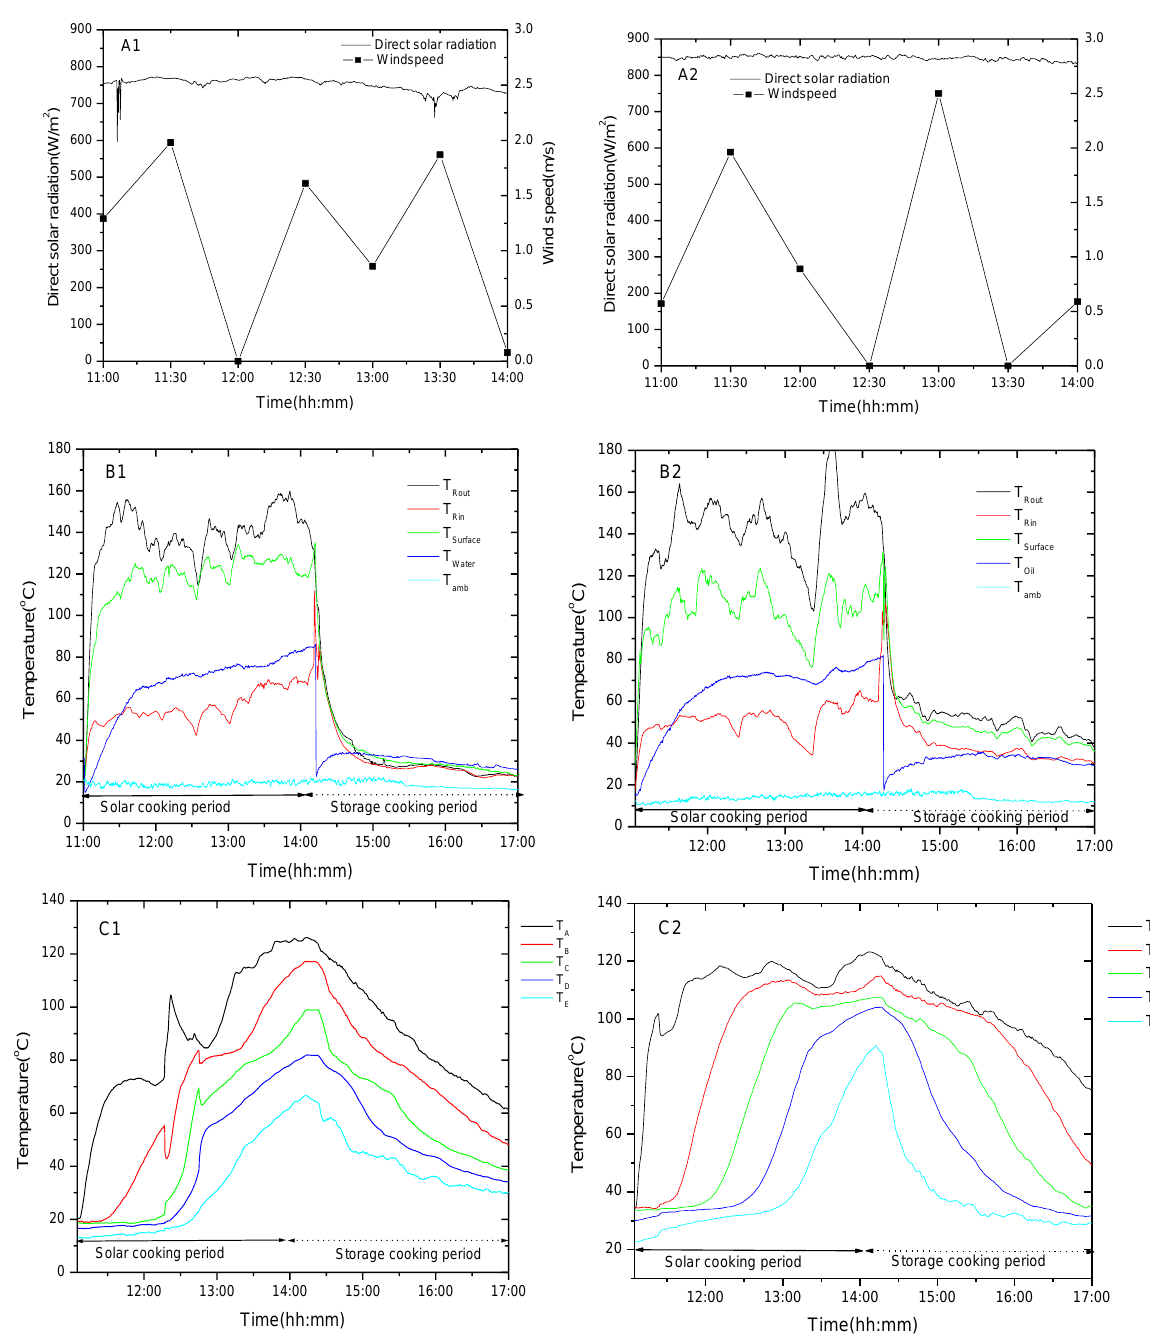
Figure 5. Experimental results of two test loads (water and sunflower oil) for a load of 1.0 kg utilizing a flow rate of 2.0 mL/s. ( A ) Direct solar radiation and wind speed ( A1 — water, A2 — sunflower oil), ( B ) the temperature profiles of the solar receiver ( B1 — water, B2 — sunflower oil), and ( C ) the temperature profiles of a storage tank ( C1 —water, C2 —sunflower oil). Experimental dates were 17 July 2021 and 20 July 2021 for water and oil tests,